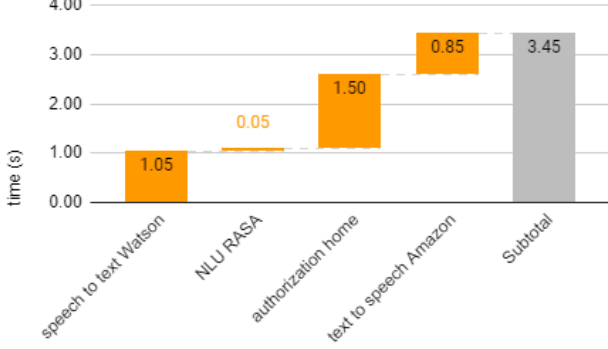
Figure 10. Total response time in the proposed solution: open architecture and non-invasive authorization.